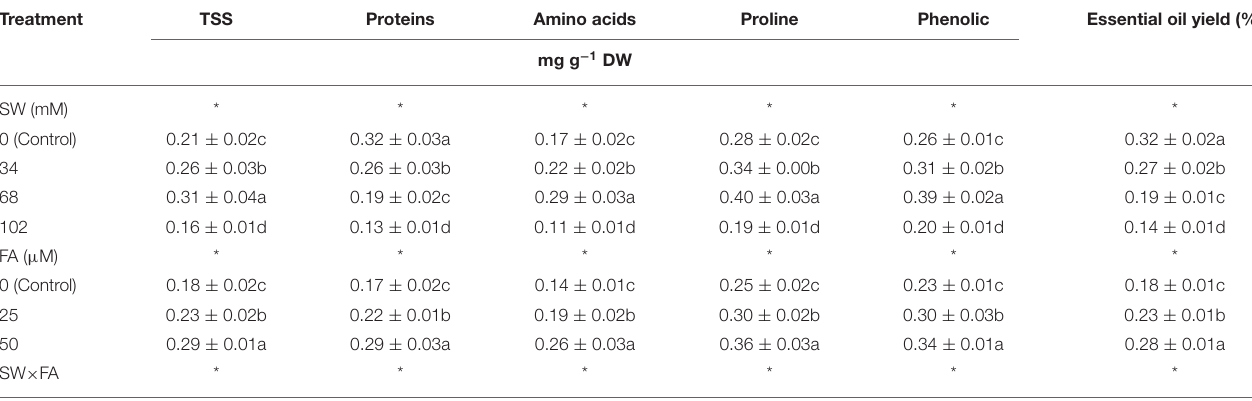
TABLE 3 | The effect of SW irrigation and FA spraying on leaf osmoprotectant compounds and essential oil yield of Plectranthus amboinicus plants grown under greenhouse conditions. Treatment TSS Proteins Amino acids Proline Phenolic Essential oil yield (%)